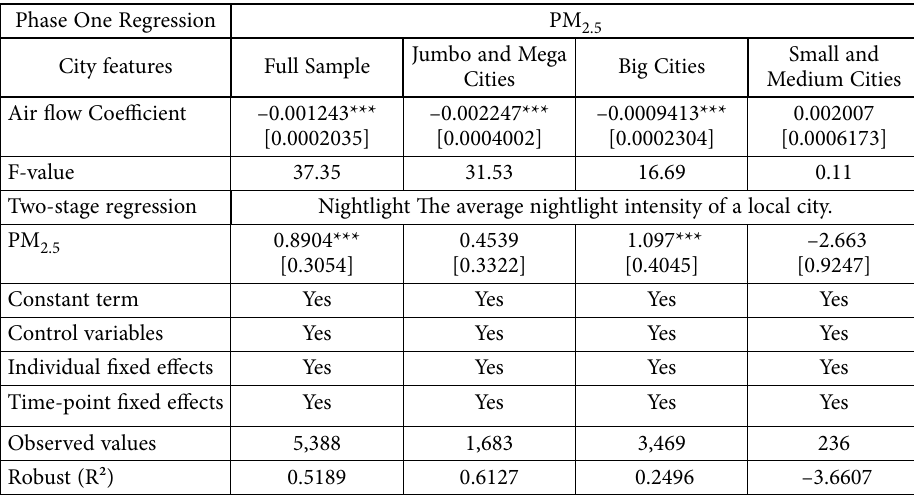
Table 9. Individual heterogeneity results for air pollution and economic growth Phase One